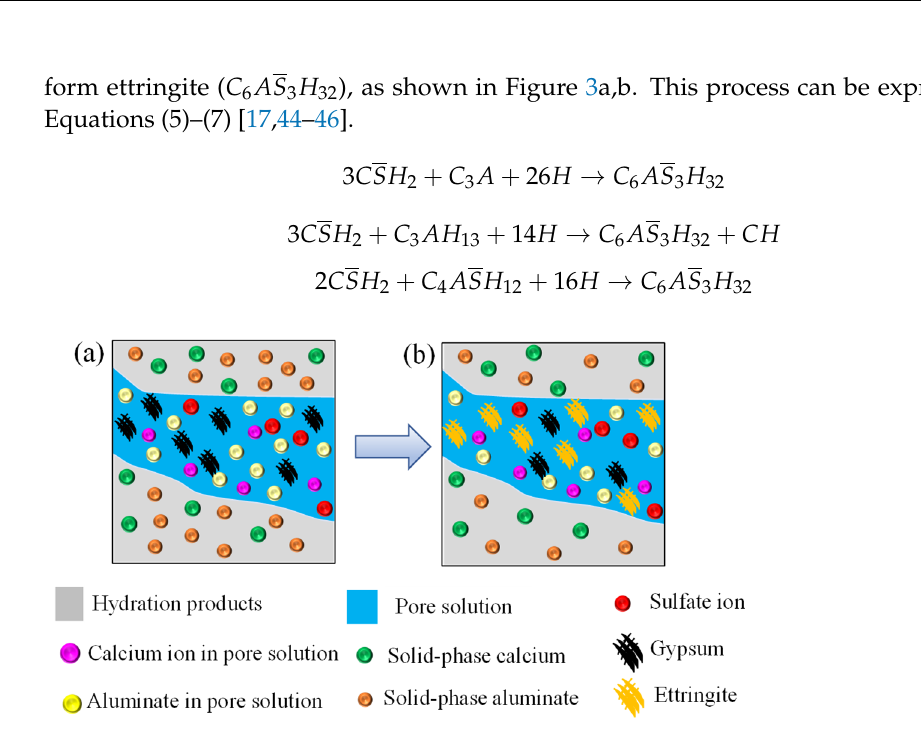
Figure 3. Schematic diagram of chemical reaction process of gypsum and aluminate. ( a ) Before chemical reaction, and ( b ) after chemical reaction.